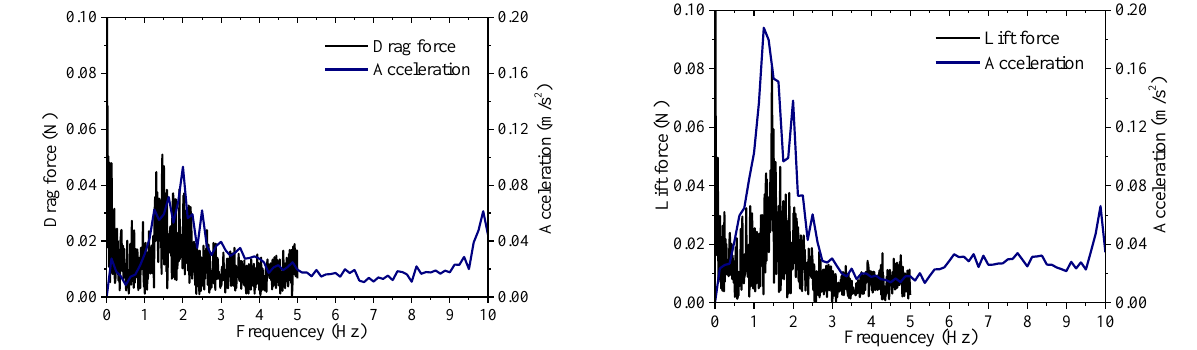
Figure 11. Spectrum diagrams of the aerodynamic force (at wind attack angle of 30°) and vibration accelerations in the corresponding direction under test condition of no end plates and expressway.